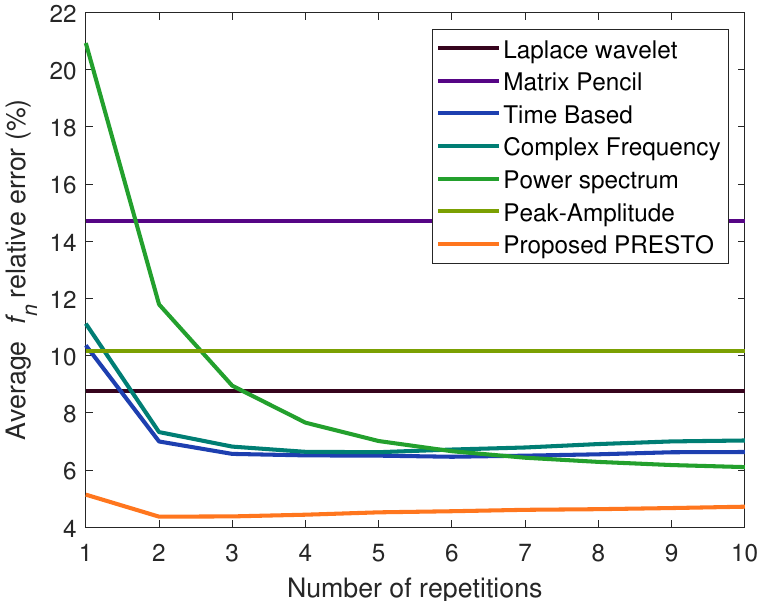
Figure 9. Average relative error (%) in the estimation of the natural frequency ( f n = ω n / ( 2 π ) ) of two simulated underdamped modes. SNR 5 dB.